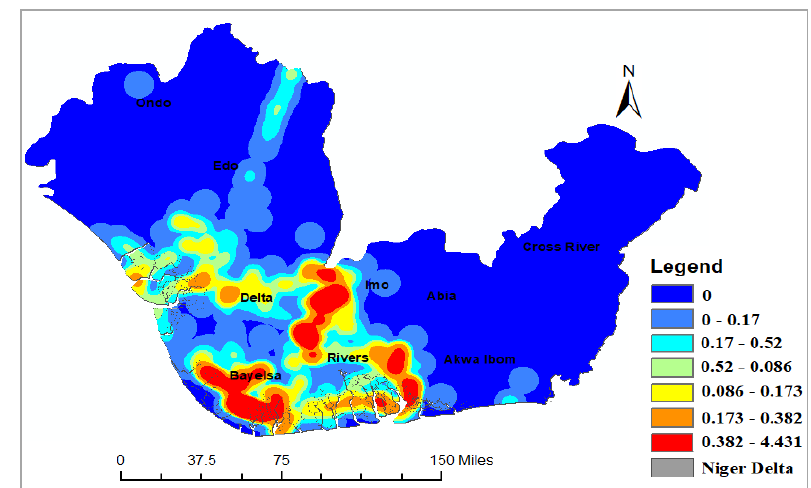
Figure 4. Oil spill hotspot map of kernel